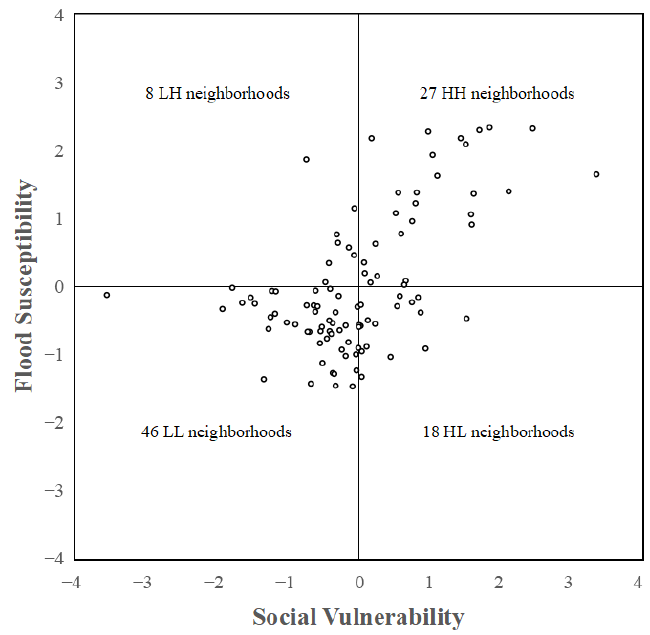
Figure 7. A two-dimensional coordinate system for social vulnerability and flood susceptibility.